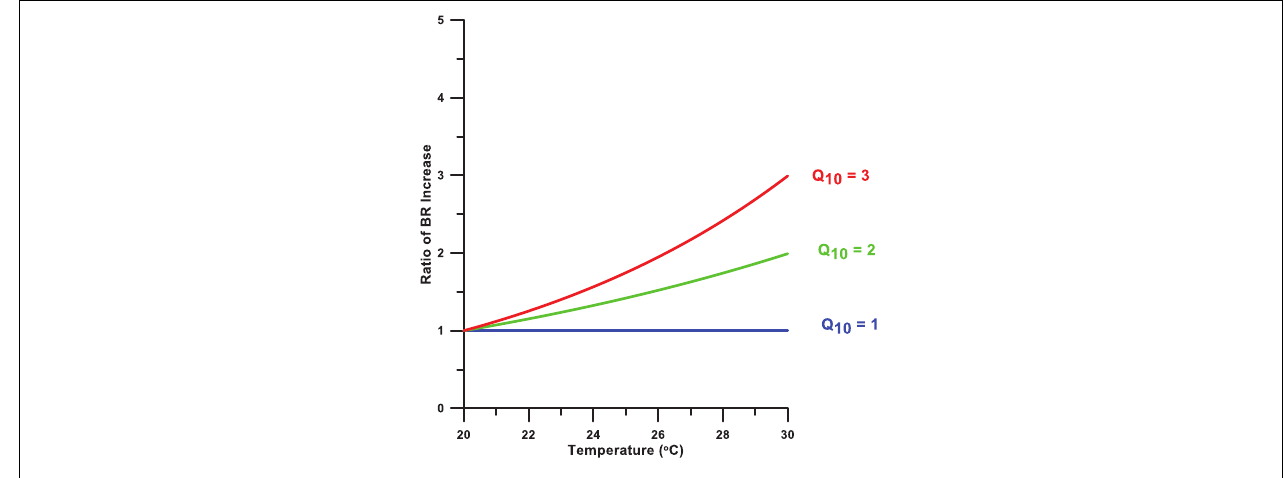
FIGURE A1 | Illustration of the temperature dependence of the rate of bacterial respiration (BR) at a range of Q 10 values starting from 20 ◦ C.